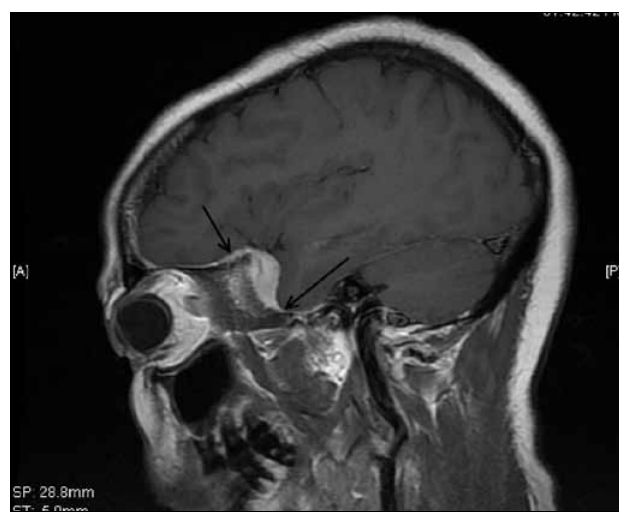
Fig. 2. Saggital T1-weighted spin-echo MR image of the brain with intravenous gadolinium of the same patient demonsrates the dural tails (arrows) of the meningioma and the hyperostosis of the adjacent bone.